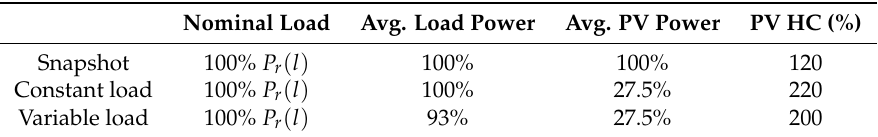
Table 4. Comparison of average output power of loads and PV units over a one-week period for three methods (100% PV penetration and nominal loading).